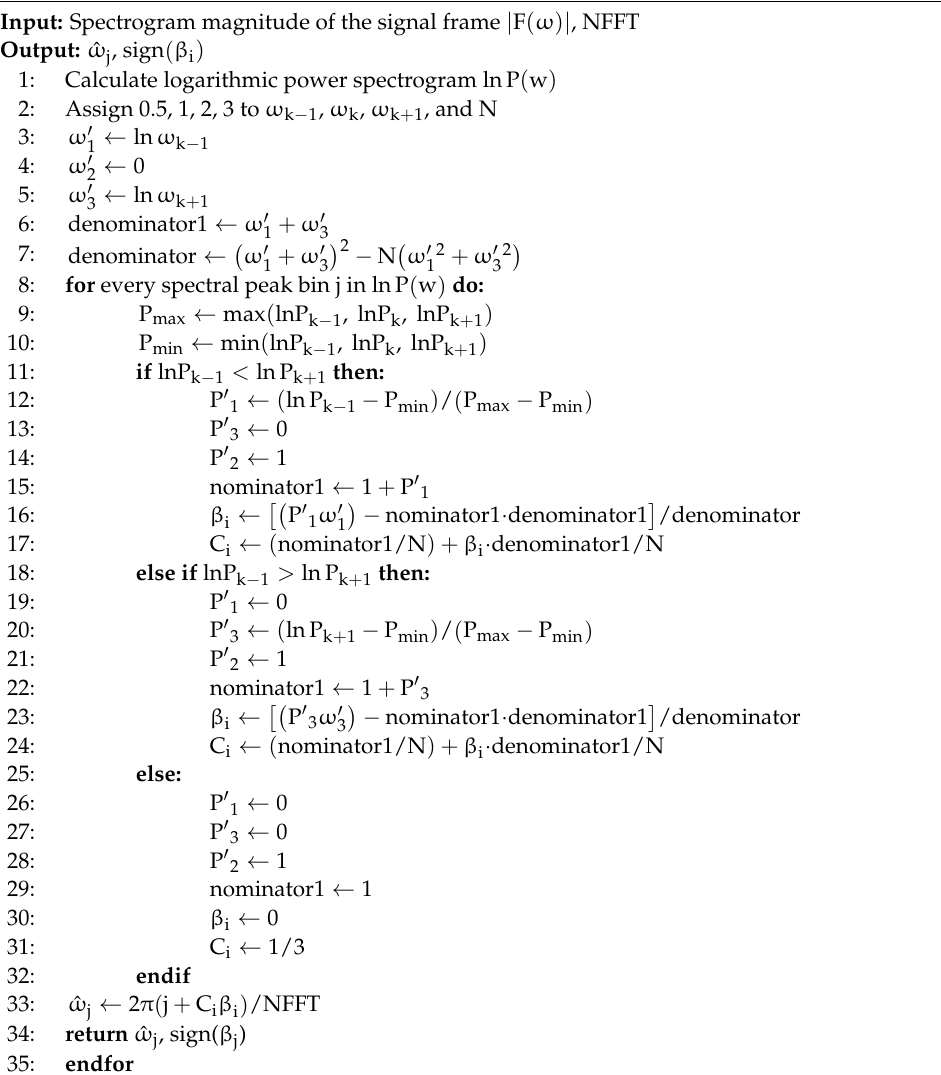
Algorithm 1. Pseudocode for FDE-based instantaneous frequency estimation on a signal